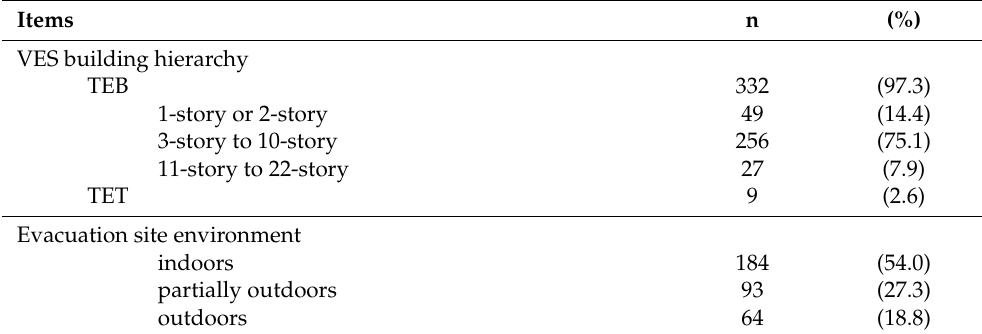
Table 2. Breakdown of VES building hierarchy and evacuation site environment (n = 341).